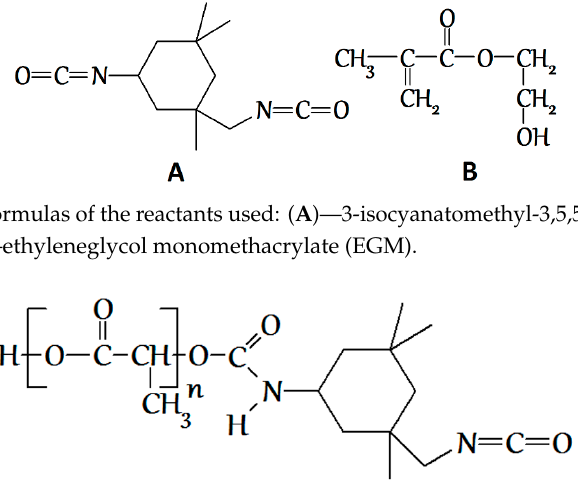
Figure 5. SEC (size-exclusion chromatography) elution profile of the reaction mixture obtained at the first stage, after its purification by reprecipitation. The red line and triangles indicate the signal boundaries of the main reaction product. In the second stage, the methacrylate PLA derivative (Figure 6) was obtained by the interaction of isocyanate groups of PLA derivative obtained at the first stage with the EGM hydroxyl groups. EGM in the amount of 0.0011, 0.003, or 0.005 mol, corresponding to the excess of 10%, 200%, or 400%, respectively, to PLA, and 0.15 mL of dibutyltin dilaurate as a catalyst were loaded into the reactor containing the reaction mixture obtained at the first stage (PLA isocyanate and unreacted ITI). The reaction was conducted in the sc СО 2 medium in the same conditions, like those at the first stage, for 10 h. The completion of the methacrylate PLA derivative formation was also controlled by SEC and IR spectroscopy via the disappearance of the isocyanate band (2268 cm − 1 ) and appearance and growth of the double bond vibration band (1637 cm − 1 ) (Figure 7) in the IR spectrum of the reaction mixture purified by reprecipitation, which, according to the SEC data (Figure 8), was free from the unreacted five-fold excess of EGM (with only one main product present). The reaction mixture after the СО 2 removal represented a dry powder, which was dissolved in chloroform and